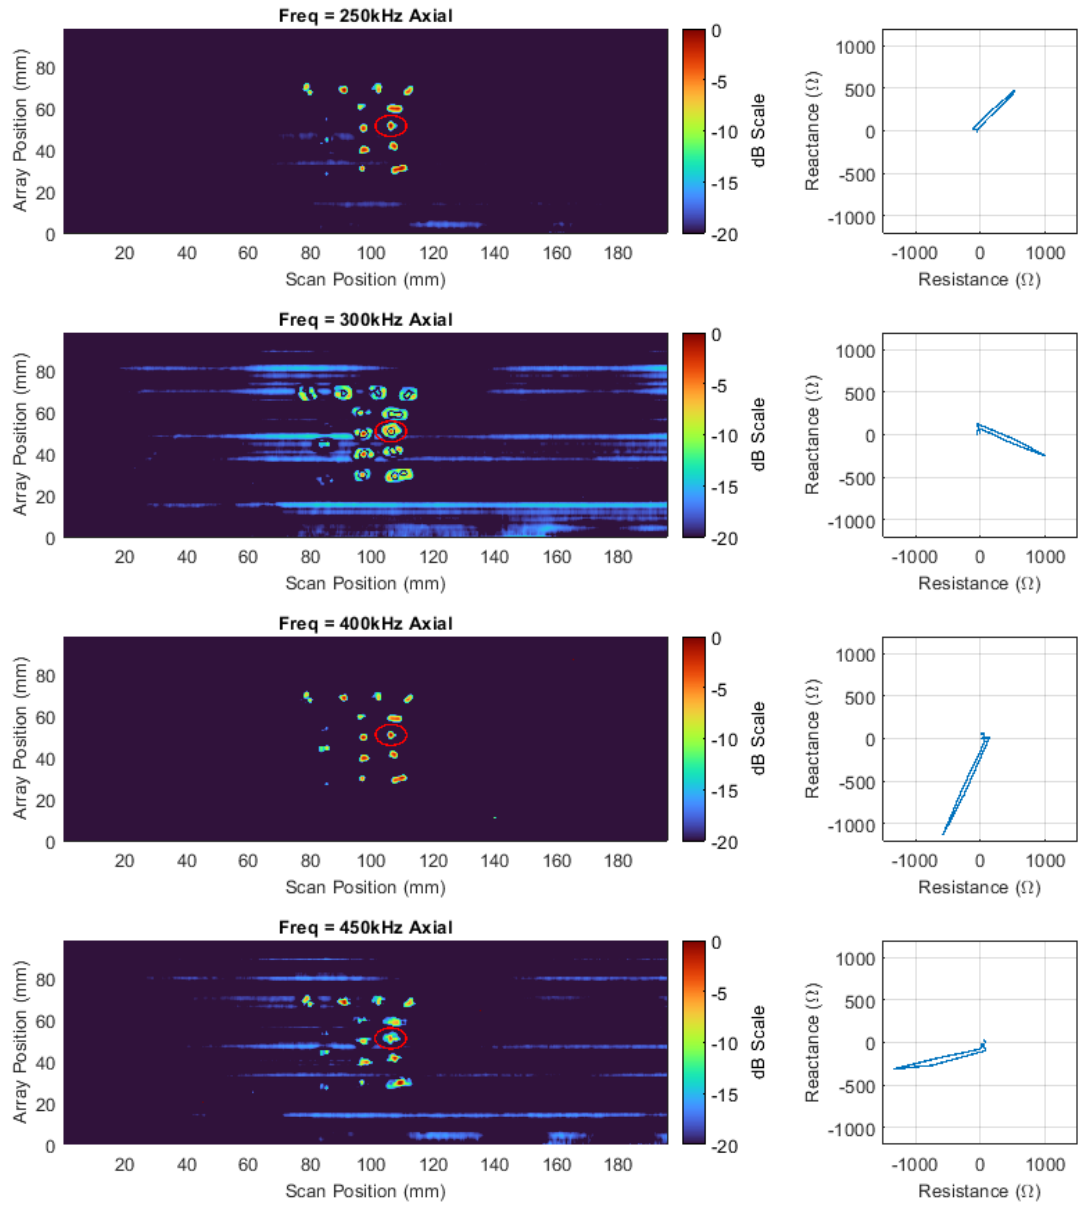
Figure 8. Axial vertical impedance component C − scan images at 250, 300, 400, and 450 kHz on a dB scale alongside impedance plane plots of the response from the highlighted defect.